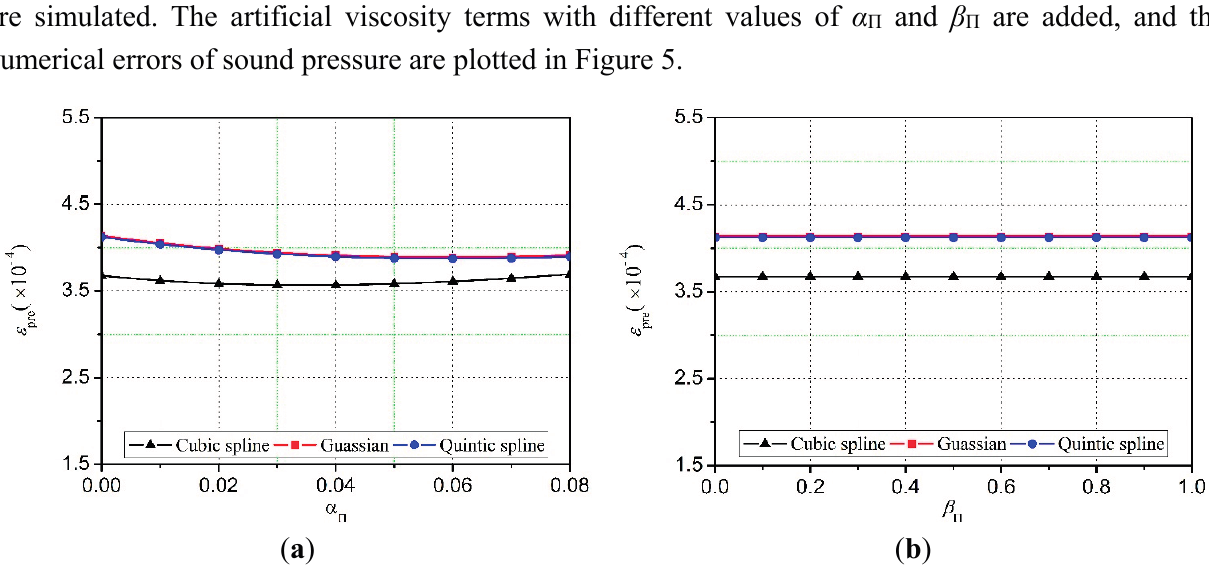
Figure 5. Numerical errors of sound pressure for sound interference models with different kinds of smoothing kernel functions. Particle spacing Δ x is 0.04 m, and the Courant number is 0.04. ( a ) Effects of α П on the simulation results at β П = 0.5; ( b ) effects of β П on the simulation results at α П =